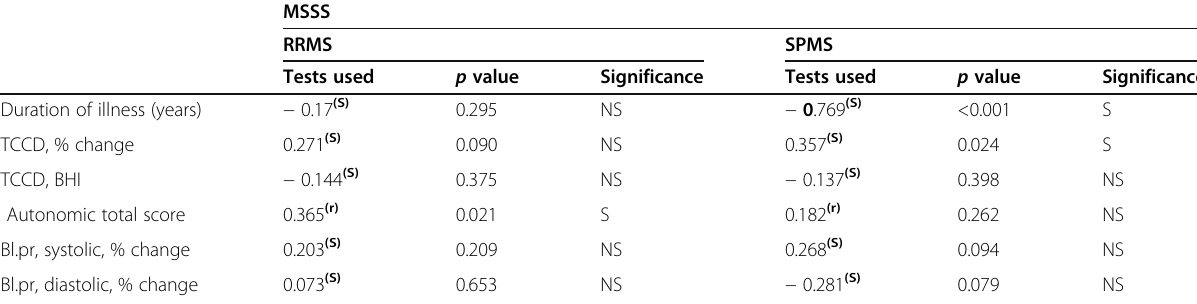
Table 2 Correlation between MSSS and TCCD, autonomic functions, and blood pressure in both case